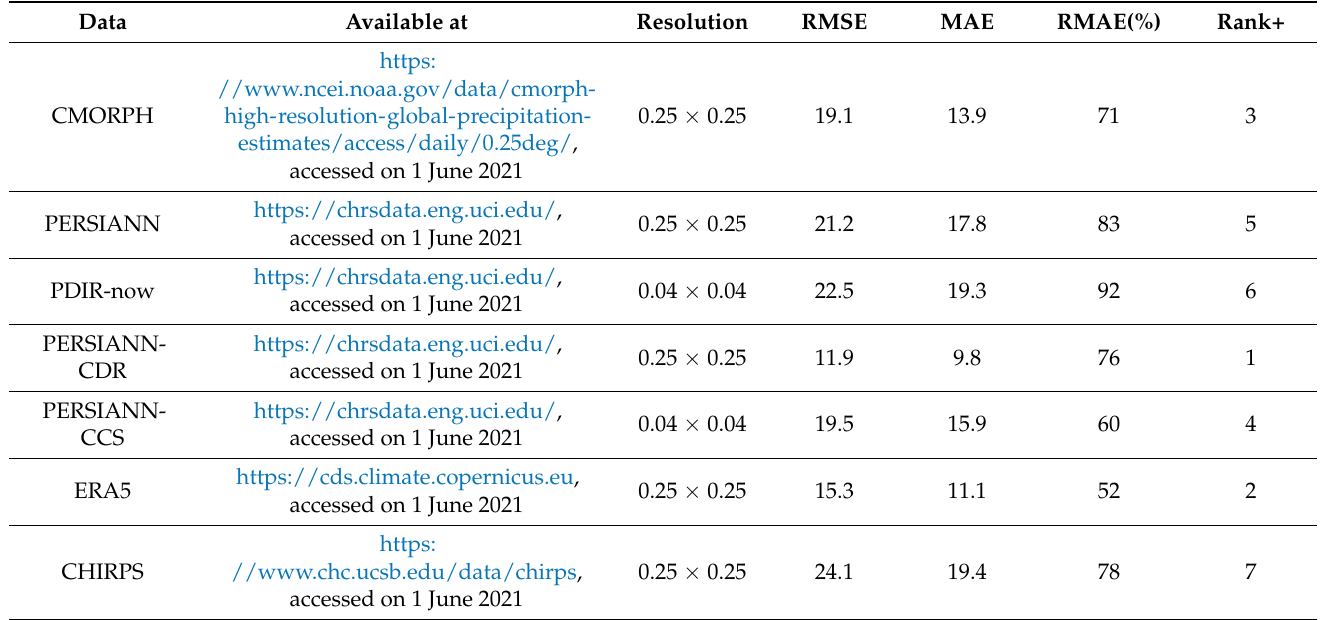
Table 3. Average estimated error indices for different satellite-based data and reanalysis data when compared with 37 rain gauges in Egyptian